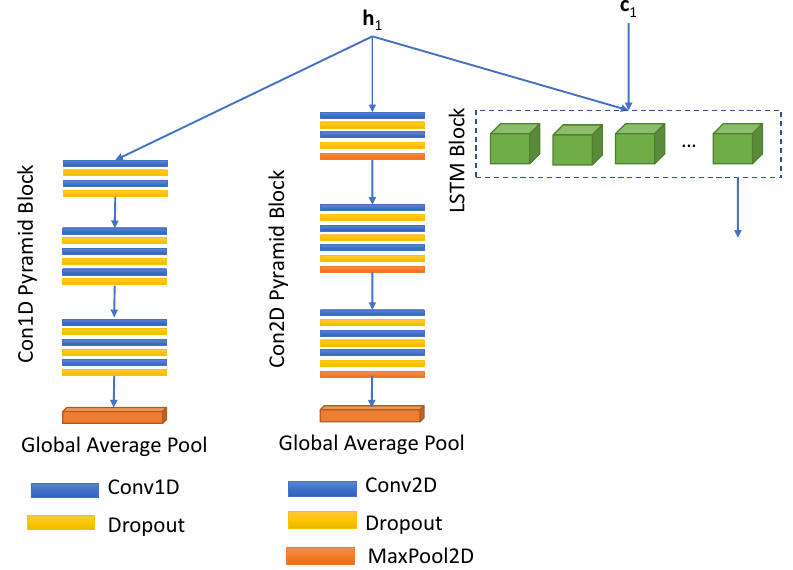
Figure 7. Multi-level feature LSTM architecture.